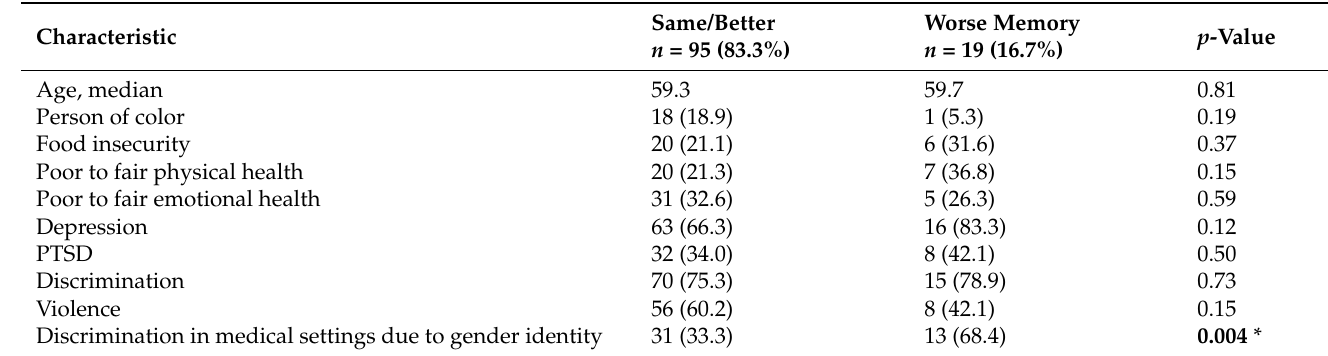
Table 3. Psychosocial Factors Associated with Worsening Memory in the Past Year Among Transgen- der and Nonbinary Older Adults.